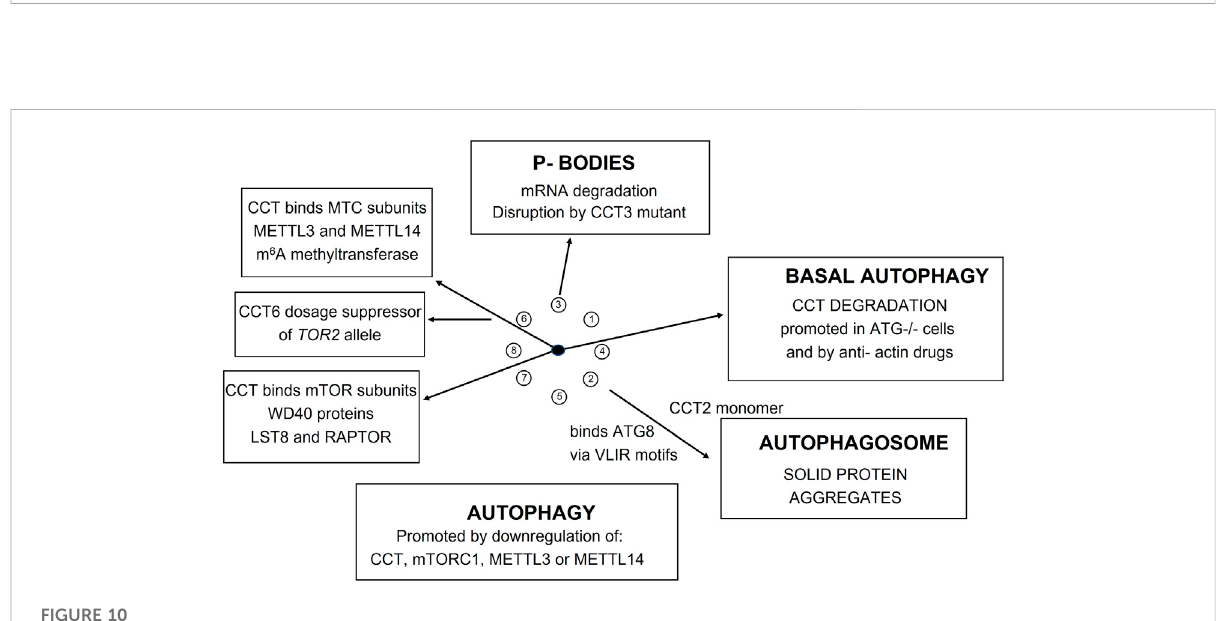
FIGURE 10 CCT involvement in mTOR pathway and